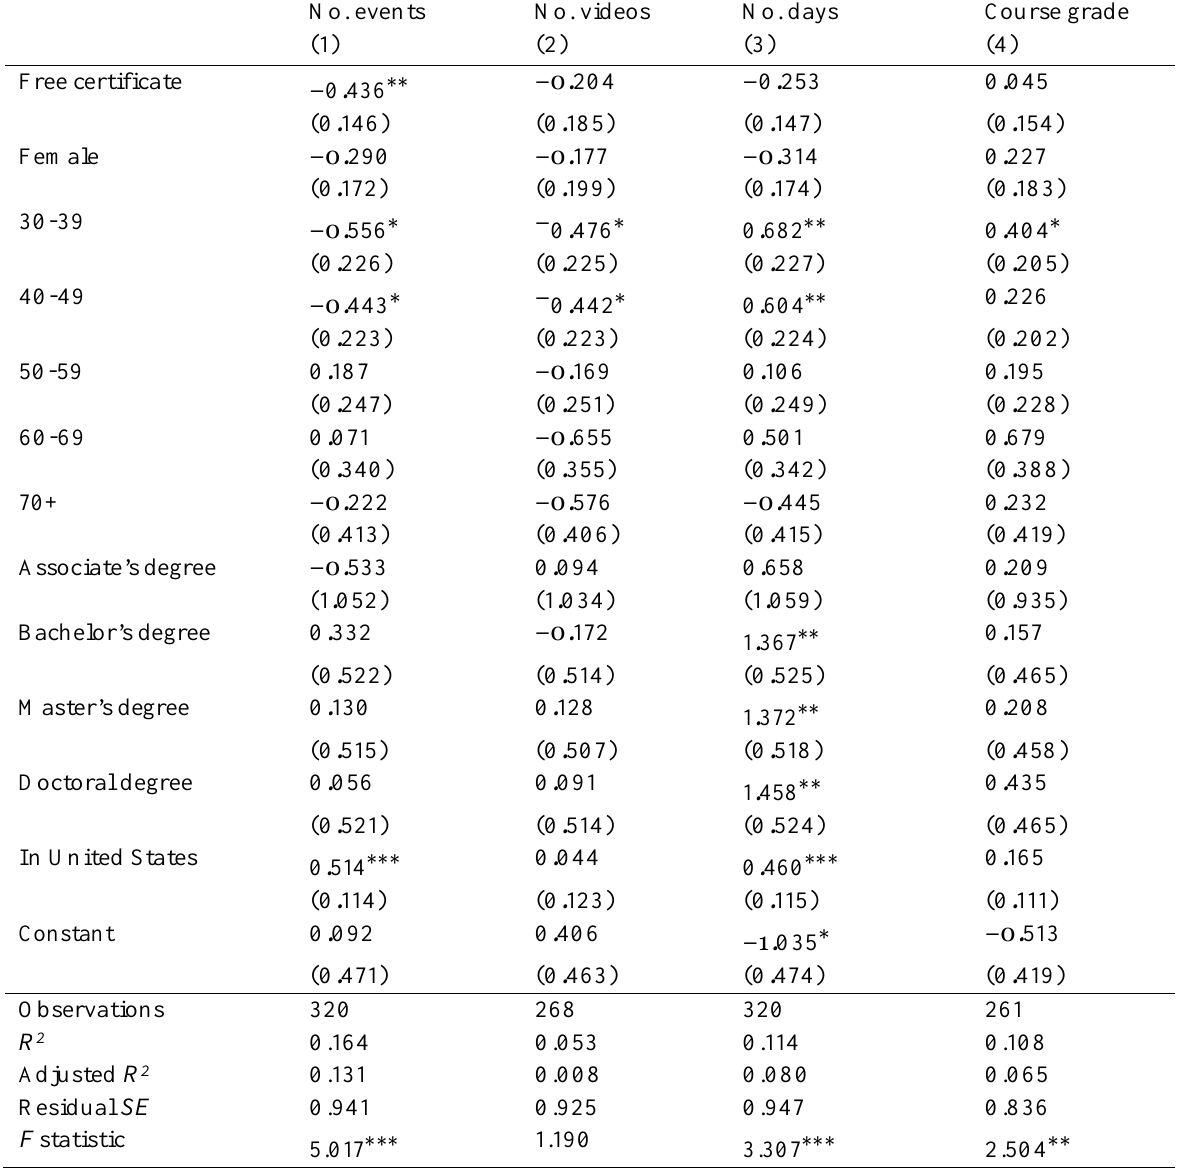
Table A2 Regression Results for Case Study